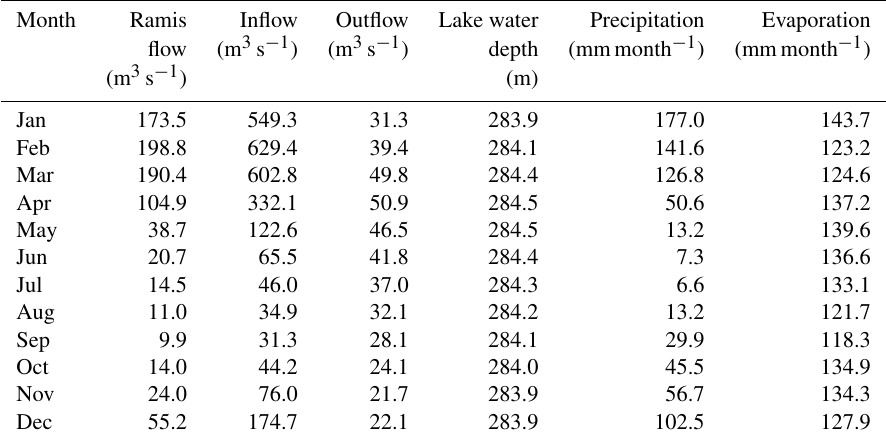
Table 6. Monthly mean water balances for Lake Titicaca for the period 1966–2011. Month Ramis Inflow Outflow Lake water Precipitation Evaporation